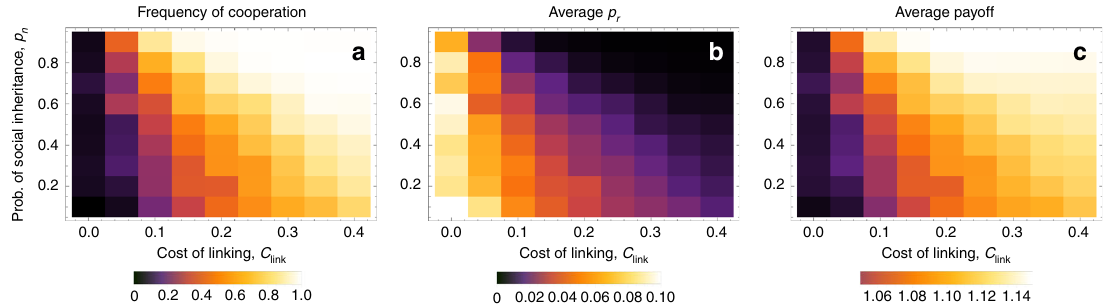
Fig. 6 Effects of exogenously fi xed probability of social inheritance p n when the probability of random linking p r is evolving. a Depicts the long-term average frequency of cooperation, b the average p r , and c average payoff. Here, B = 2, C = 0.5, D = 0, μ = μ link = 0.001, σ r =